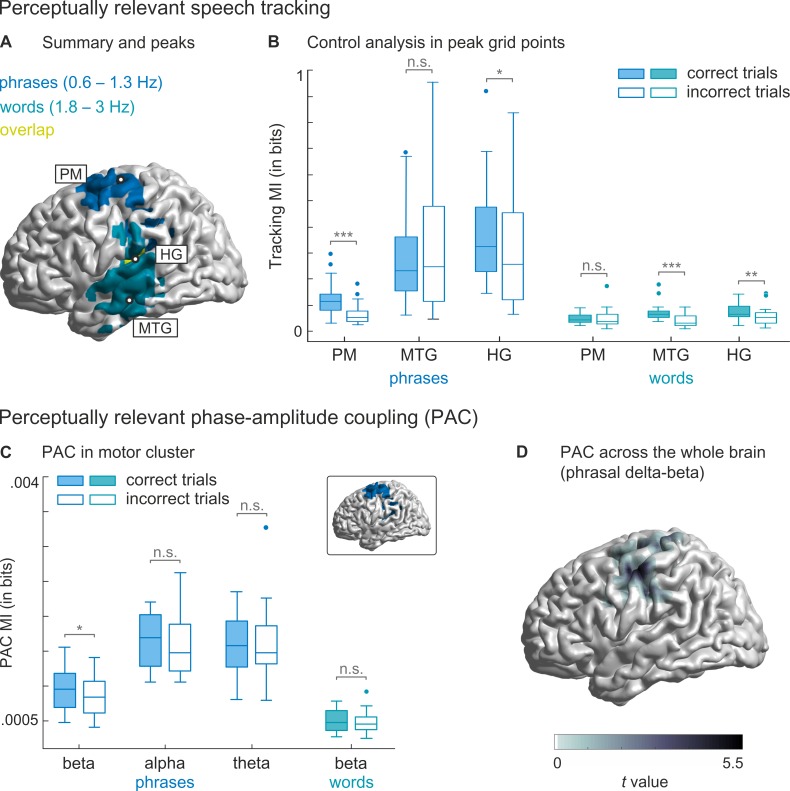
Summary of perceptually relevant effects and control analyses.(A) Brain regions with perceptually relevant speech tracking. For phrases (blue), the effect was strongest in the left PM area. For words (turquoise), it was strongest in the left MTG. Areas that were perceptually relevant for both phrases and words (yellow) include left HG and supramarginal gyrus. Peak grid points are denoted with circles. (B) Comparison of tracking MI values at peak grid points in PM cortex, MTG, and HG for phrase and word scales. Boxes denote interquartile range with median line; error bars show minimum and maximum, excluding outliers. (C) MI between the phase at the phrasal timescale (0.6–1.3 Hz) and power in beta, alpha, and theta bands (blue plots), as well as the phase at the word timescale (1.8–3 Hz) and beta power (turquoise plot) for correctly and incorrectly comprehended trials, averaged across all grid points in the motor cluster (cluster shown in inlet). Only PAC between the phase at the phrasal timescale and beta power was perceptually relevant. (D) Whole-brain analysis across all 12,337 grid points confirming that PAC between phrasal phase and beta power is indeed confined to motor regions. Coloured area denotes the cluster where PAC between phrasal phase and beta power was larger for correctly comprehended than uncomprehended trials. Significance in panel B and C is denoted with: *** = p < .001, ** = p < .01, * = p < .05. Data deposited in the Dryad repository: https://doi.org/10.5061/dryad.1qq7050 [31]. HG, Heschl gyrus; MI, mutual information; MTG, middle temporal gyrus; n.s., not significant; PAC, phase-amplitude coupling; PM, premotor.